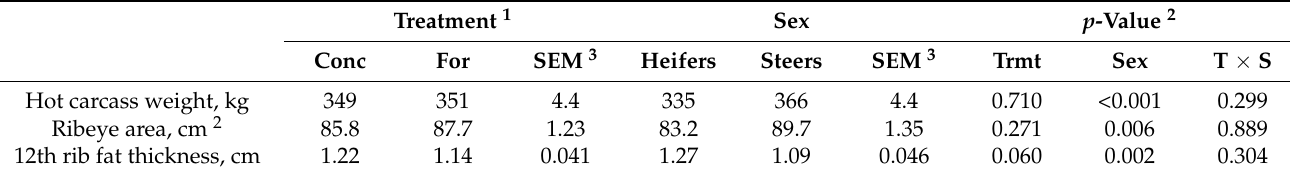
Table 5. Least square means for carcass characteristics and meat quality of progeny from dams fed a prepartum dietary carbohydrate source consisting of concentrate-based (Conc) or forage-based (For) diet during mid- and late-gestation. Treatment 1 Sex p -Value 2 Conc For SEM 3 Heifers Steers SEM 3 Trmt Sex T × S Hot carcass weight, kg 349 Ribeye area, cm